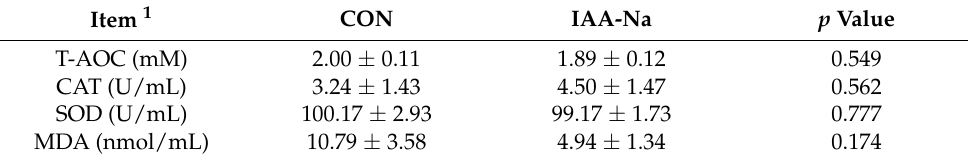
Table 4. Effect of dietary IAA-Na supplementation on serum antioxidant activity in Danzhou chickens.